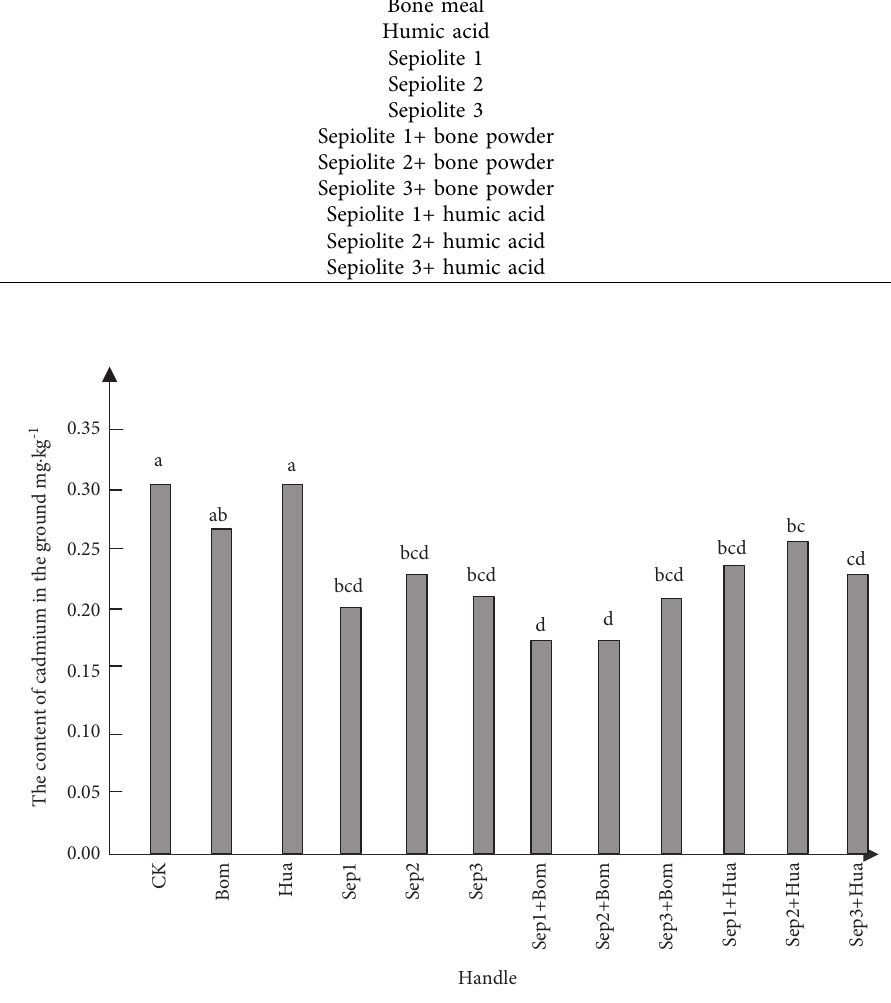
Figure 1: Effect of passivation treatment on the content of cadmium in the upper part of lettuce.